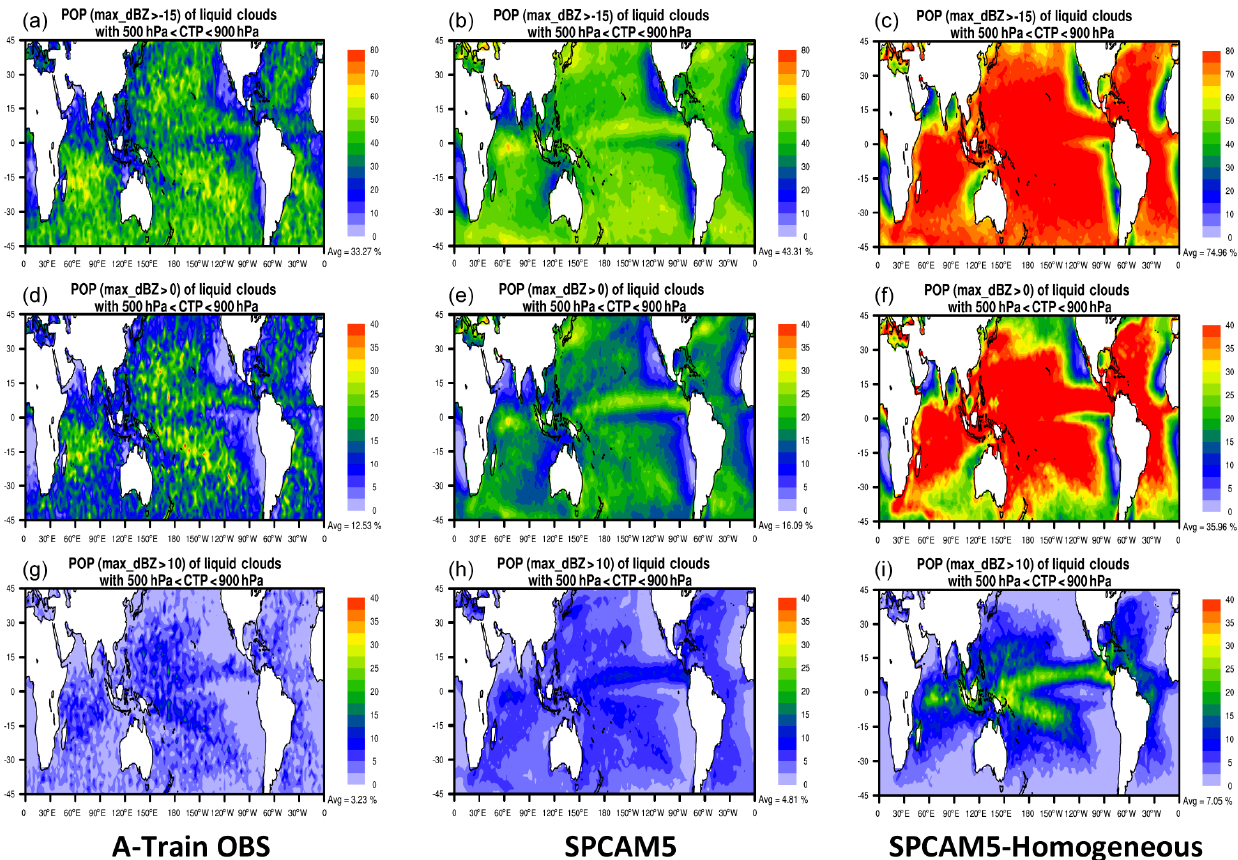
Figure 5. Probability of precipitation (POP) of liquid clouds between 500 and 900hPa levels in the satellite observations (a, d, g) , the SPCAM5 COSP simulation (b, e, h) , and the SPCAM5-Homogeneous COSP simulation (c, f, i) . Three categories of precipitation: drizzle plus rain (column Z max > − 15dBZ, a , b , c ), rain (column Z max > 0dBZ, d , e , f ), and strong rain only (column Z max > 10dBZ, g , h , i ). Unit of POP is